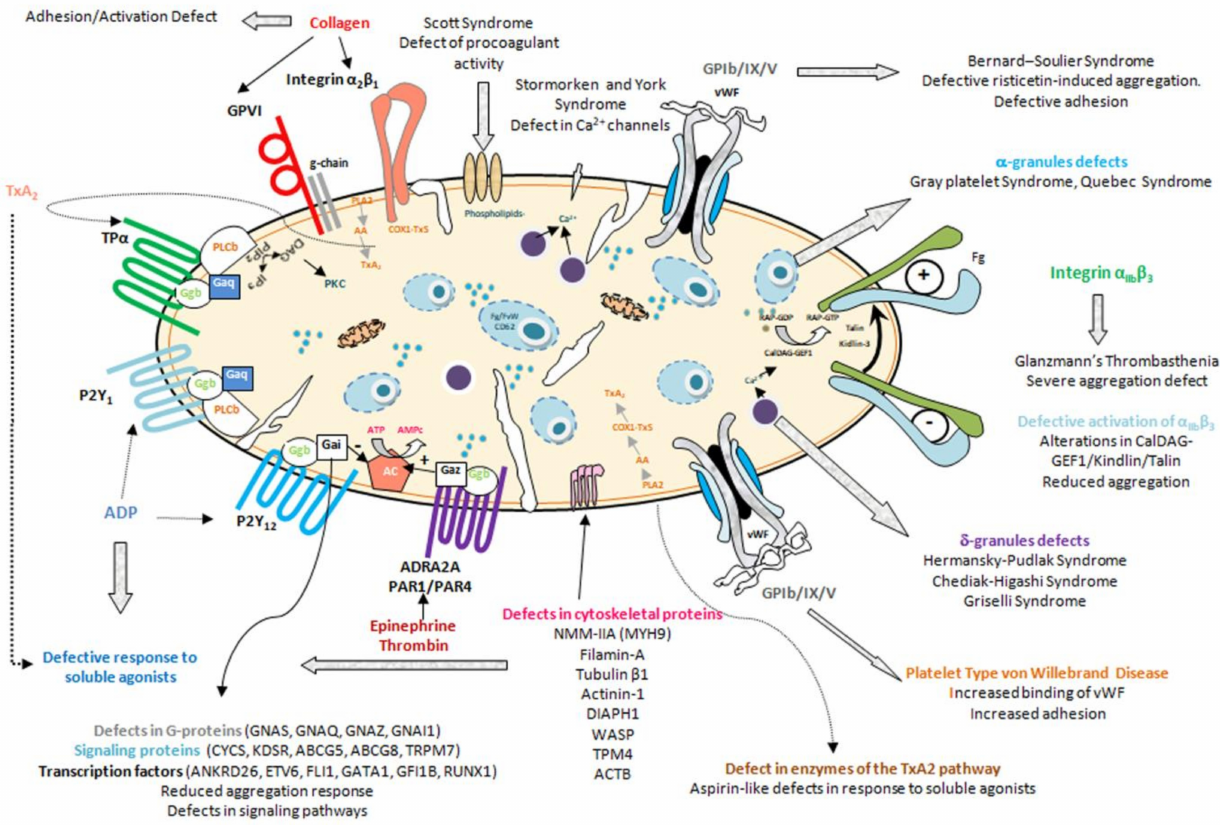
Figure 1. Inherited Platelet Disorders. The image shows the myriad of IPDs according to the protein and/or platelet function element which is affected by the genetic